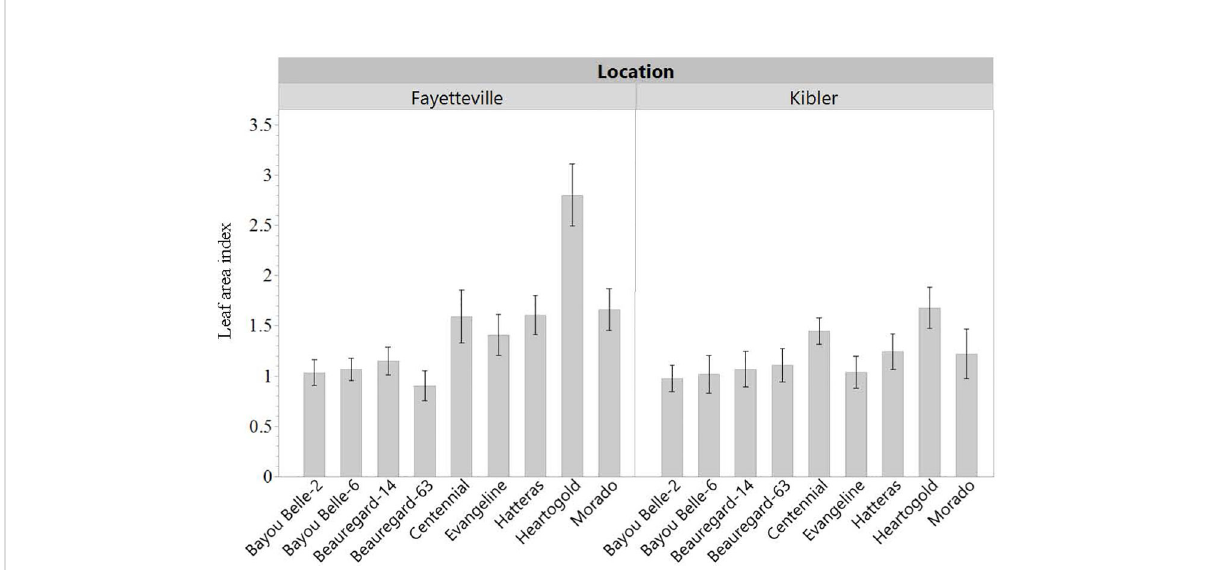
FIGURE 6 Leaf area index (LAI) of sweetpotato cultivars averaged across weedding treatments in Kibler and Fayetteville, AR, 2021. LSD to compare cultivars within location Fayetteville: 0.23; LSD to compare cultivars within location Kibler: 0.15. Bars represent standard